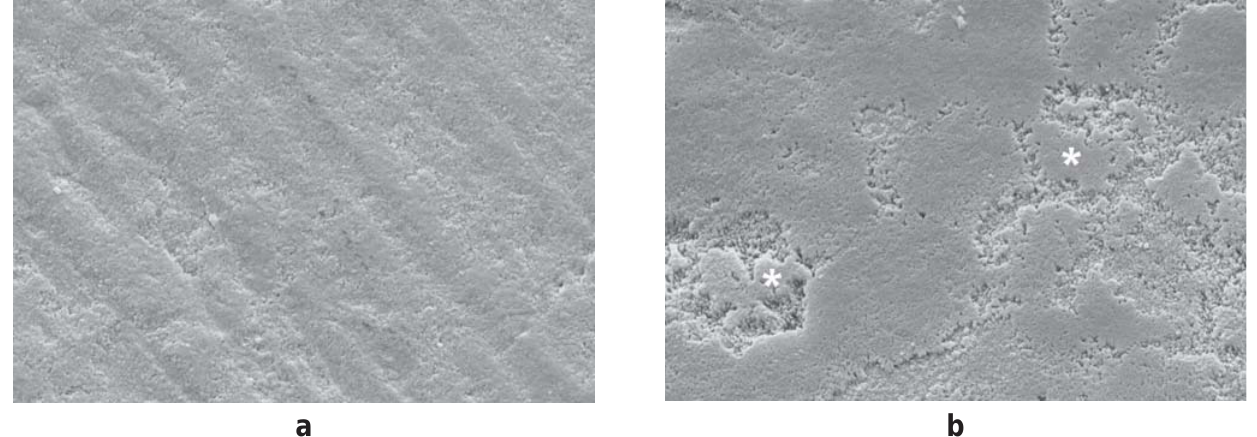
FIGURE 7- SEMs of ground (7a) and intact (7b) enamel surfaces treated with One-Up Bond F self-etching adhesive. Adhesive treatment resulted in a mild etching pattern. The aprismatic layer (*) remained after treatment (7b) (x10,000)